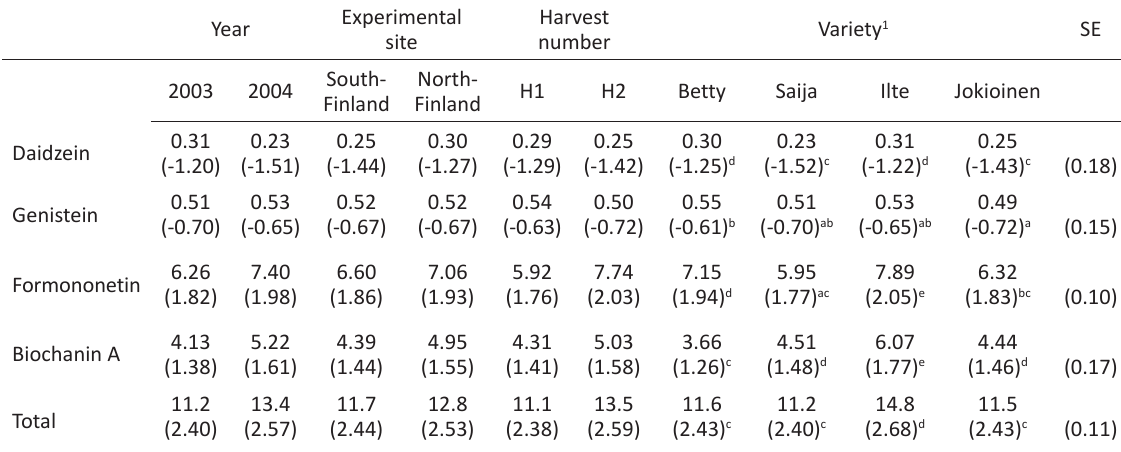
Table 2. The mean isoflavone concentrations for red clover, mg g -1 dry matter. Natural logarithmic transformed means are presented in parentheses.